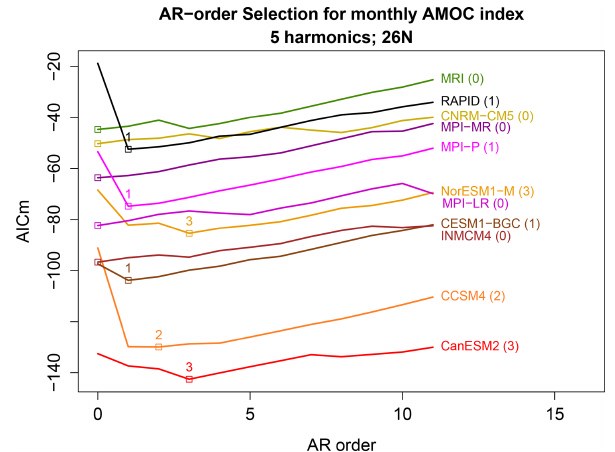
Figure 4. The AICm for fitting time series from each CMIP5 model to ARX models of the form (3), as a function of the order of the AR process p and for the number of annual harmonics H = 5. The minimum AICm for each CMIP5 is indicated by a square, and the associated order is indicated above the square (provided it is greater than zero). AICm has not been offset for each model – the different levels of AICm reflect differences in time series.